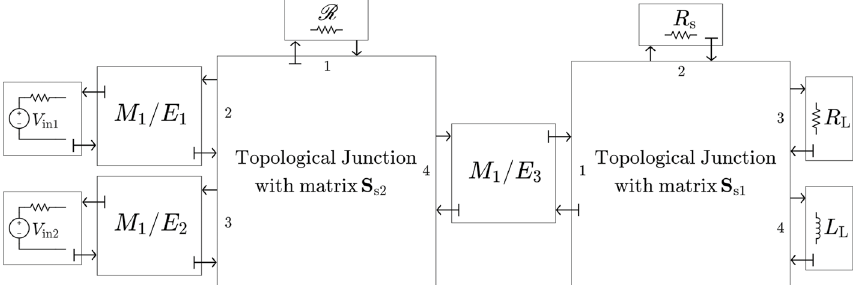
Fig. 15 WD structure implementing the output stage of a vacuum tube guitar amplifier in a multiphysics fashion. The T-shaped stubs indicate port